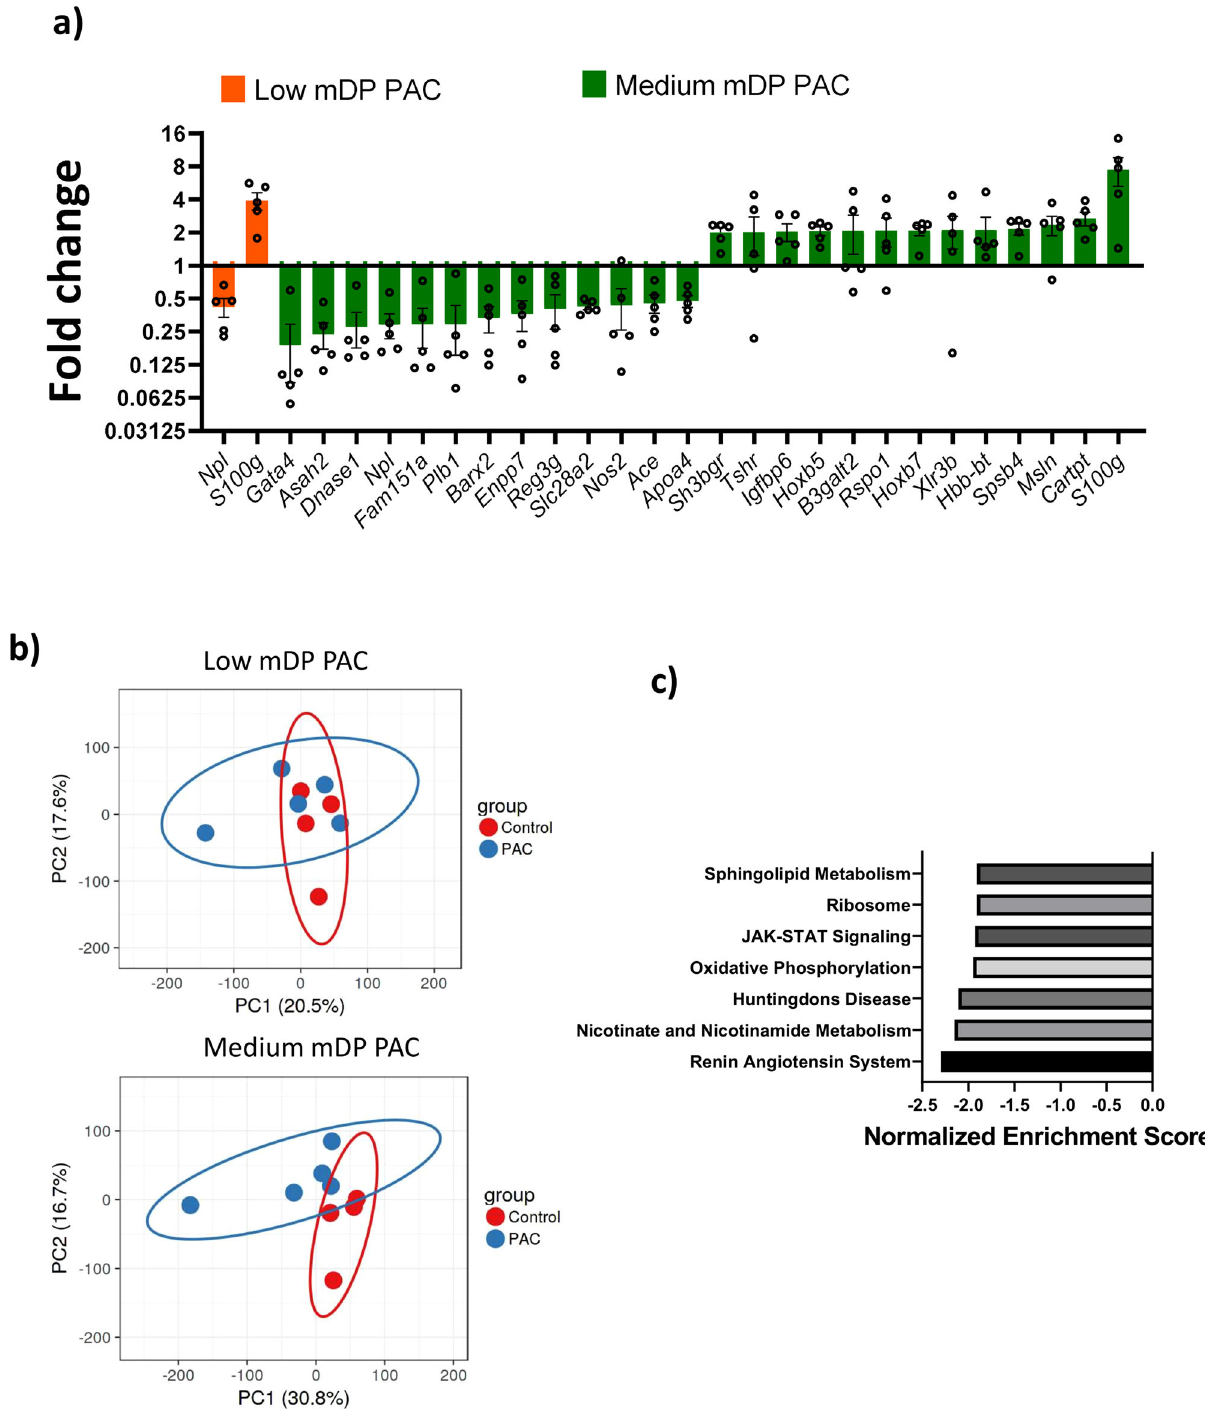
Fig. 5 Regulation of gene expression in mouse ileum tissue by proanthocyanidins. a Signi fi cantly regulated genes (fold change >2; q value >0.8 by NOIseq analysis) obtained from RNA sequencing of mouse ileum tissue in mice dosed with low mDP proanthocyanidins (PAC) or medium mDP PAC. Fold changes are relative to mice dosed with only water. n = 5 mice per treatment group. b Principal component analysis showed an effect of PAC mDP demarcated in two distinct clusters. n = 5 mice per treatment group. c Gene pathways identi fi ed in the KEGG database that were downregulated ( p value <0.005; q value <0.1) by treatment with medium mDP PAC, identi fi ed by gene-set enrichment